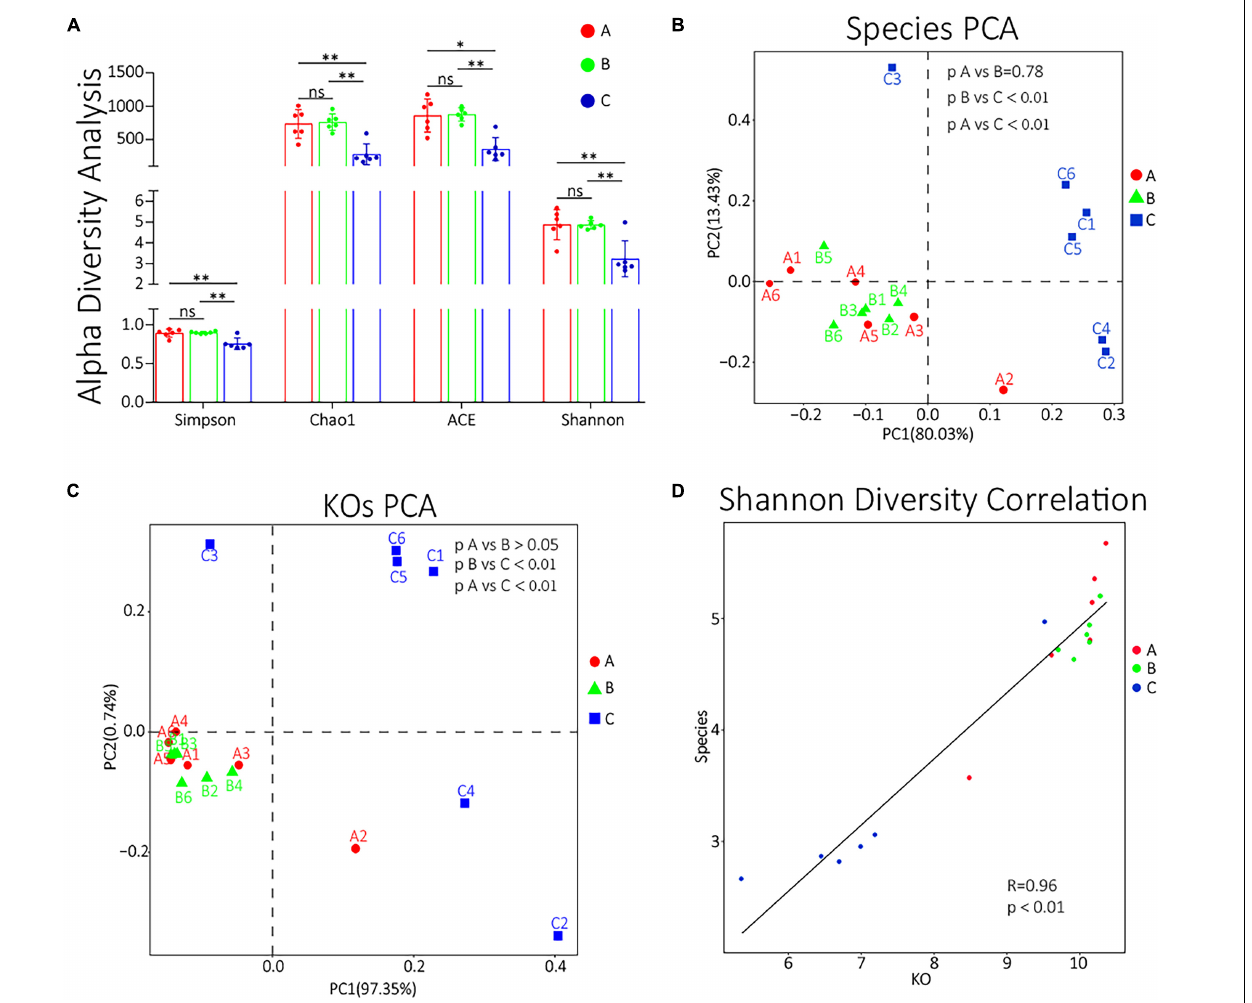
FIGURE 4 | (A) α diversity indexes of each group. ns, non-significant; ∗ 0.01 < p < 0.05; ∗∗ p < 0.01. (B,C) The species PCA and KOs PCA, respectively, of each sample. (D) The Pearson correlation analysis of the Shannon diversity indexes of KOs and species. The abscissa represents the Shannon diversity index corresponding to the KO abundance spectrum of each sample, and the ordinate represents the Shannon index corresponding to the composition spectrum of each sample at the species level. The straight line represents the fitting results by Pearson correlation